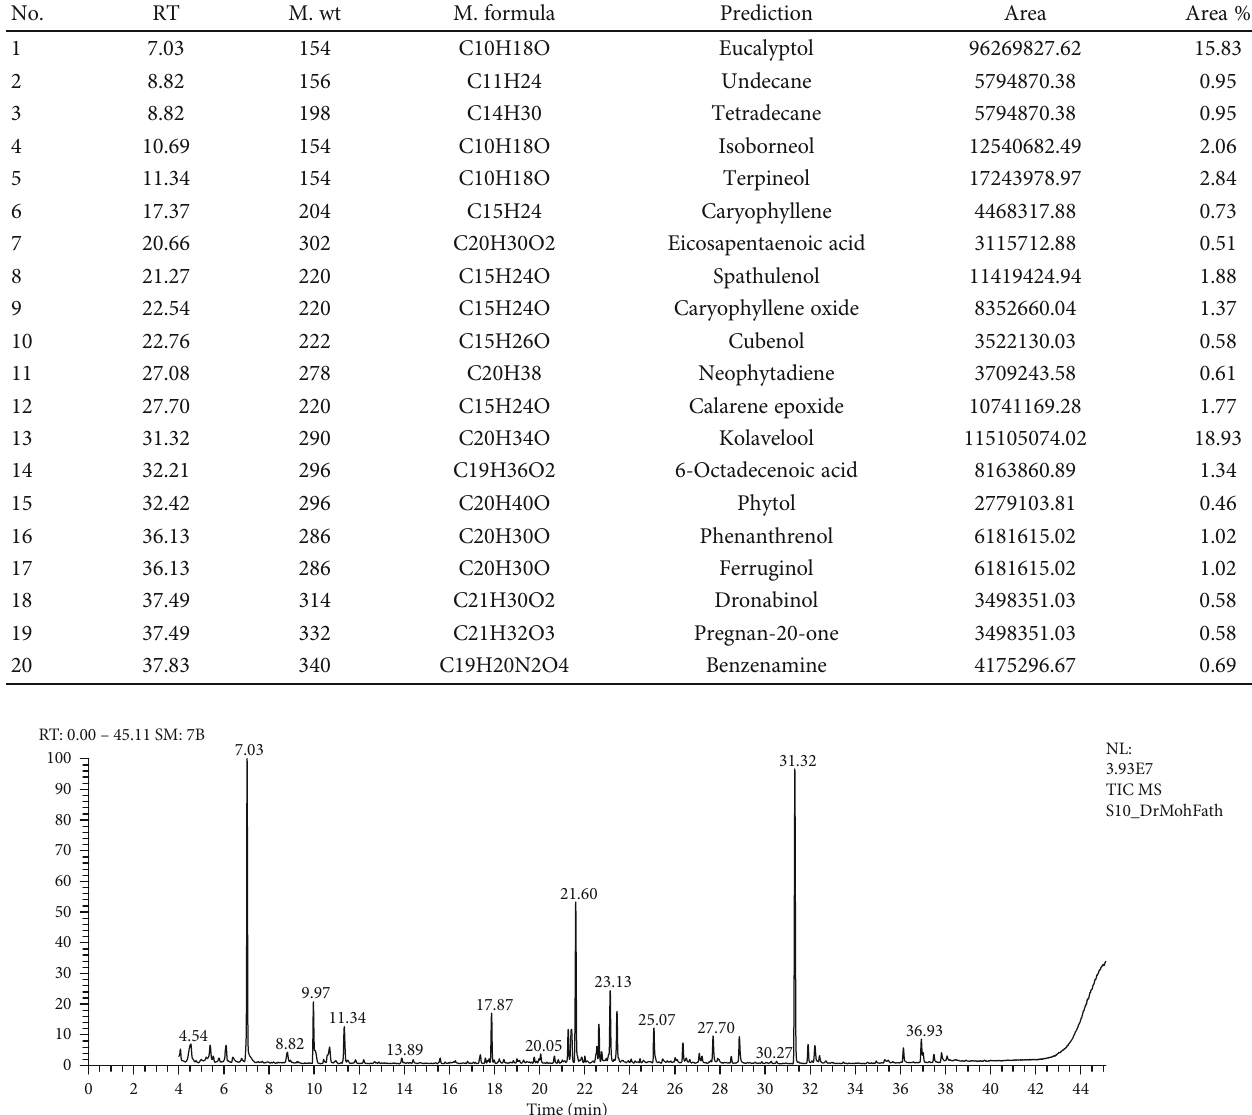
Figure 3: GC-MS chromatogram of aqueous plant extract of Coriandrum sativum